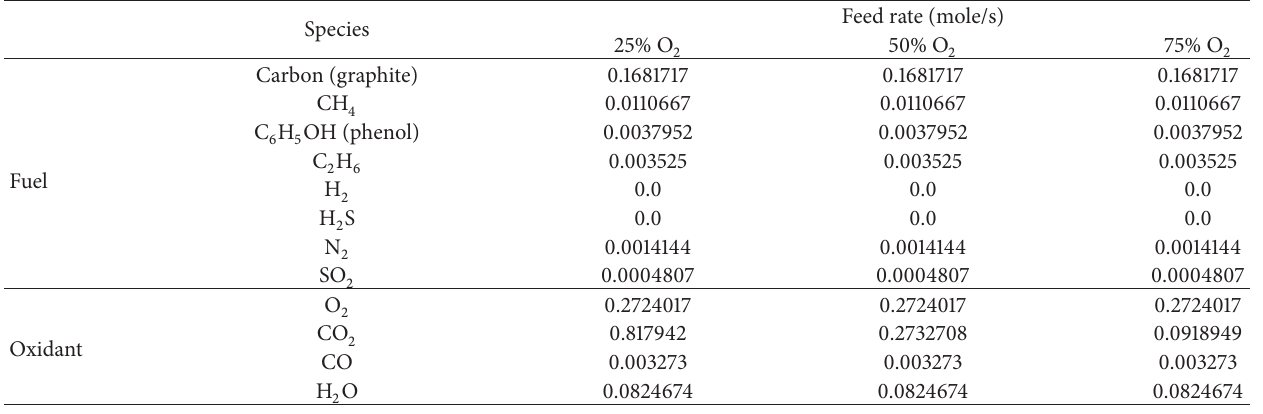
Table 4: Reduced order model (ROM) case study NASA CEA inputs.